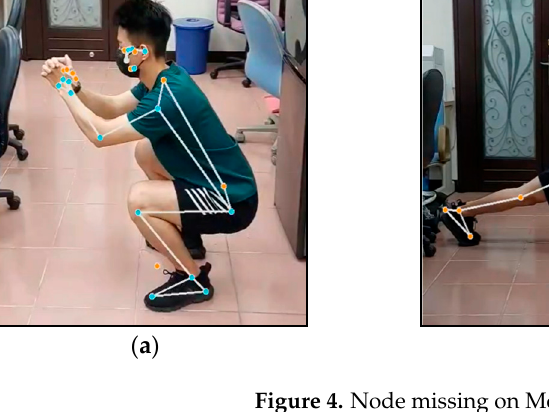
Table 6. Result of Mediapipe and Yolov4 detecting fitness.